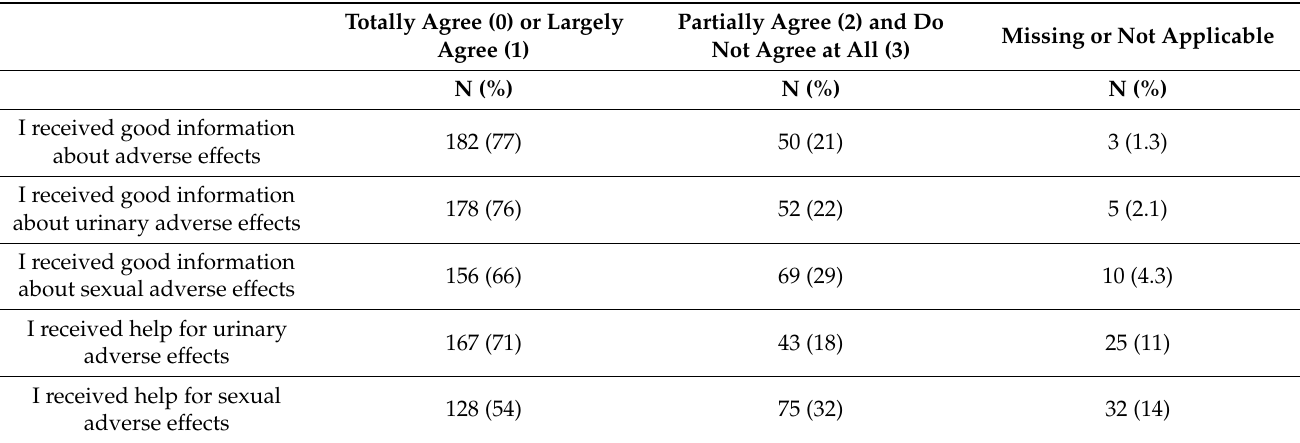
Table 1. Descriptive statistics with distributions of answers of perceived quality of information and help to cope with adverse effects at